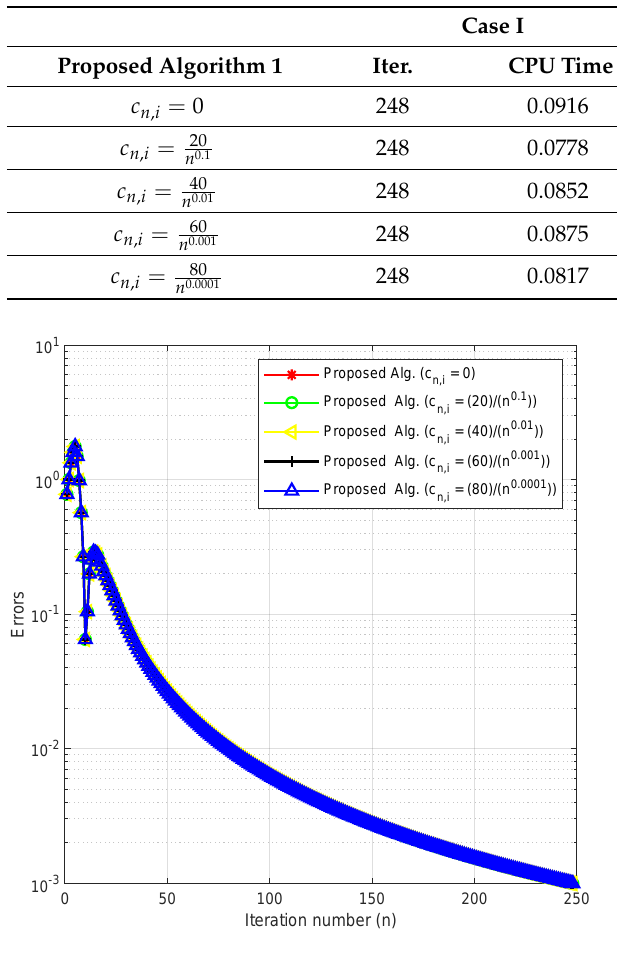
Figure 5. Experiment 2: Case